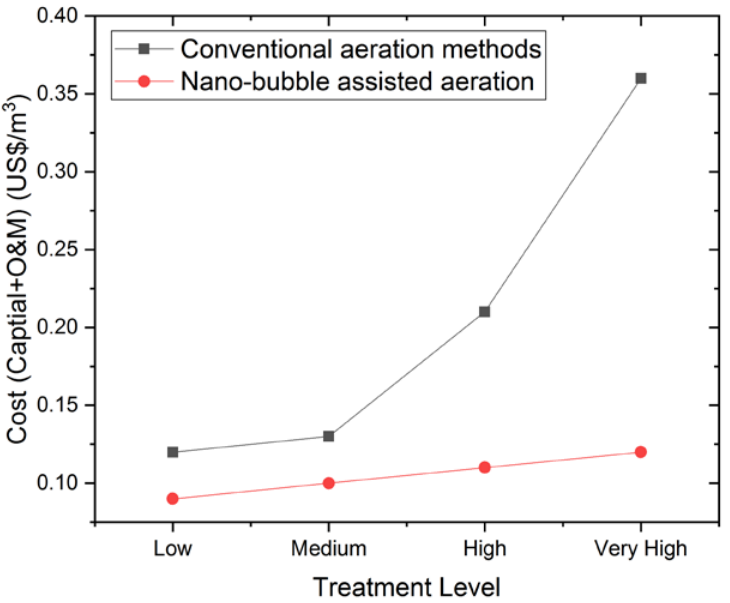
Figure 4. The total cost (rolled-up CAP- and OP-EX) of wastewater treatment as a NPV, which depends on the technological aspects as well as the water quality to which the water is treated. Treatment costs increase exponentially with improved water quality, with respect to established aeration approaches. Black curve: Cost of wastewater treatment for increased output. Low: BOD >60 mg/L; Medium: BOD 20–60 mg/L, TSS 30–90 mg/L; High: MBTP, BOD, and TSS levels of 20 and 30 mg/L, respectively. Red curve: Refers to the cost estimation of innovative ultra-dense NB technology, [64,81], which provides an essentially linear scale vis-à-vis treatment level. Image credit: M.R. Ghaani.